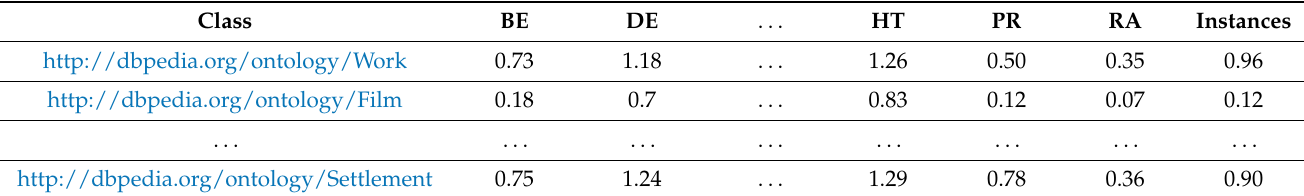
Table 2. Example Input